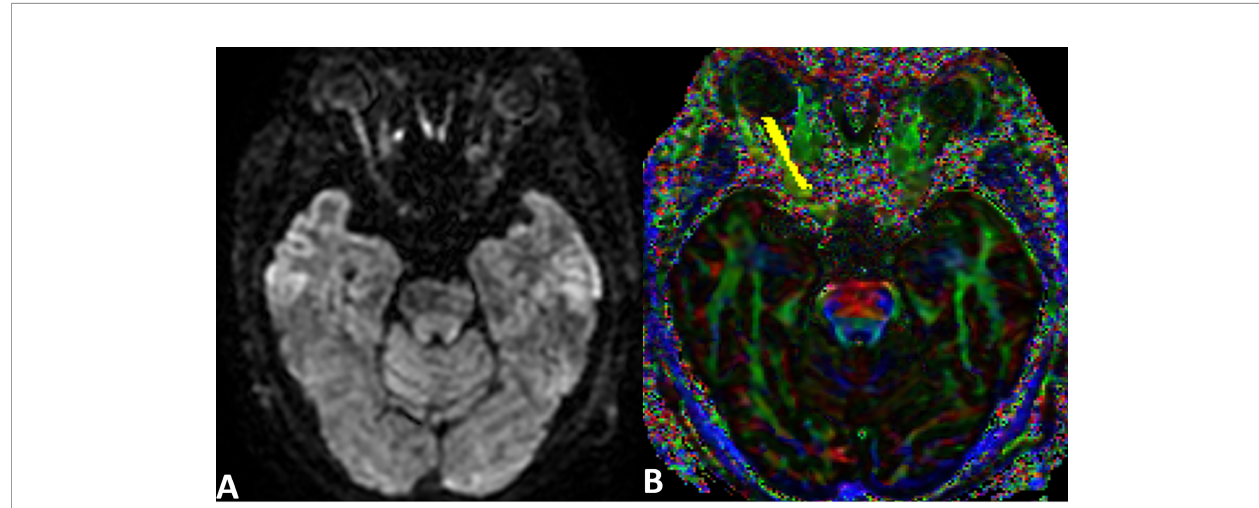
FIGURE 1 | An example raw DWI image and DTI color map of the optic nerve. (A) A raw DWI image of the optic nerve. (B) A combined FA and directional color map of the optic nerve generated by MRI Studio. The region of interest is indicated in yellow. The color hue indicates direction as follows: red, left-right; green, anteroposterior; blue,